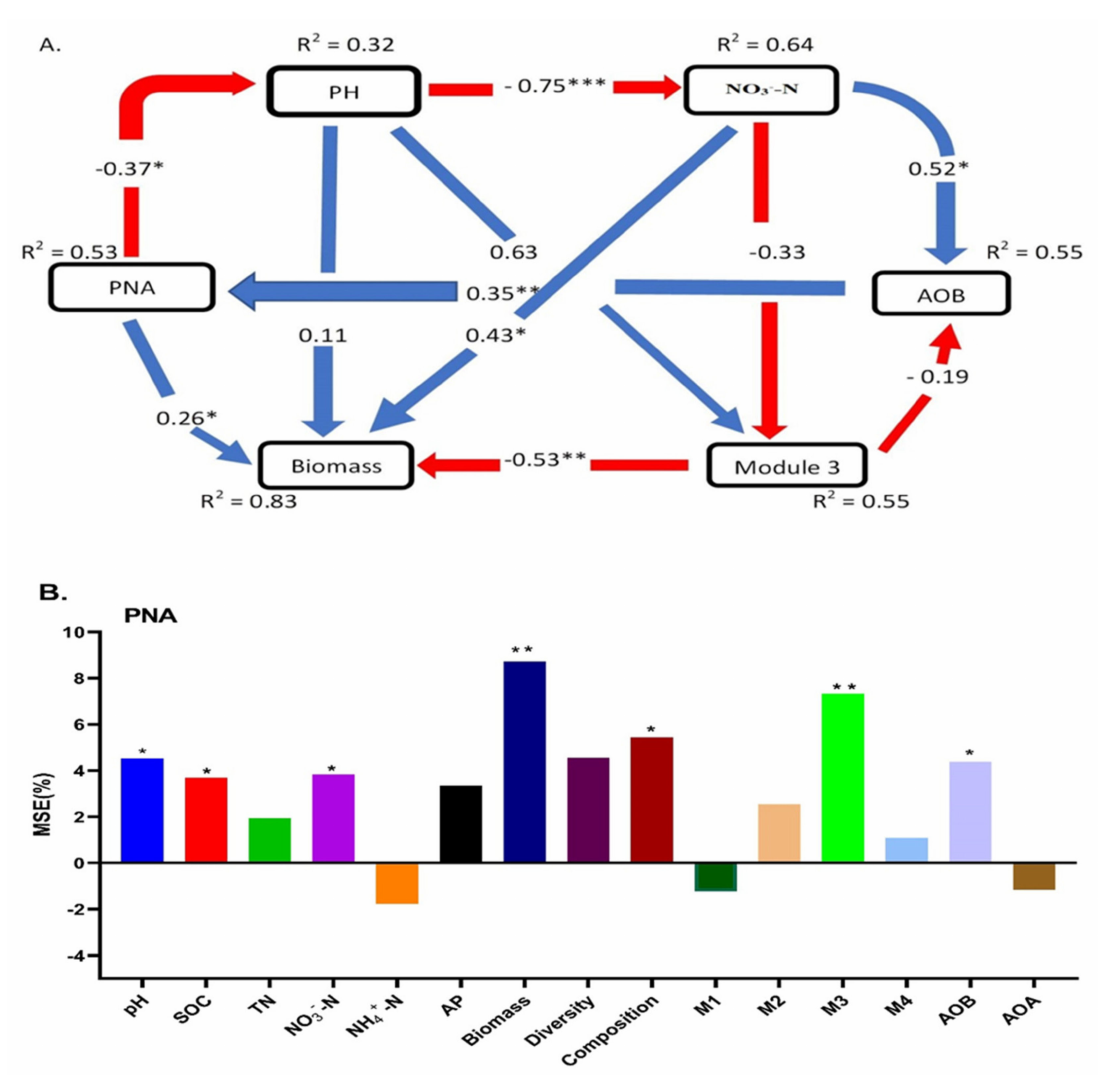
Figure 8. ( A ) Influence of the direct and indirect effects on abiotic/biotic variables on ammonia-oxidizing archaea bacteria (AOB) abundance using structural equation modeling (SEM). ( B ) The individual significant AOB variables were selected via random forest analysis. Among the abiotic variables were soil pH and N0 3 − N, while within the biotic variables were biomass, nitrification, and Module 3. Numbers on arrows are standardized path coefficients. R 2 indicates the proportion of variance explained. Results of model fitting: chi-square = 6.6, d.f = 4, p < 0.05, root mean square errors of approximation (RMSEA) = 0.22, Akaike information criterion (AIC) = 40.55. Blue and red arrows specify positive and negative respectively. *** p < 0.001; ** p < 0.01; * p < 0.05. (B) Random forest modeling was performed using our 15 soil amendments (5 treatments × 3 replications). MSE (%) = mean squared error (MSE). The total effects on AOB abundance by abiotic variables include the following soil properties: soil pH; SOC = soil organic carbon; total nitrogen (TN); ammonia nitrogen (NH 4+ -N); nitrate-nitrogen (N0 3 − -N); available phosphorus (AP). Biotic variables also included PNA = Potential nitrification activity, Biomass, diversity = (PCoA), composition = Shannon, and Modules 1, 2, 3, and 4,